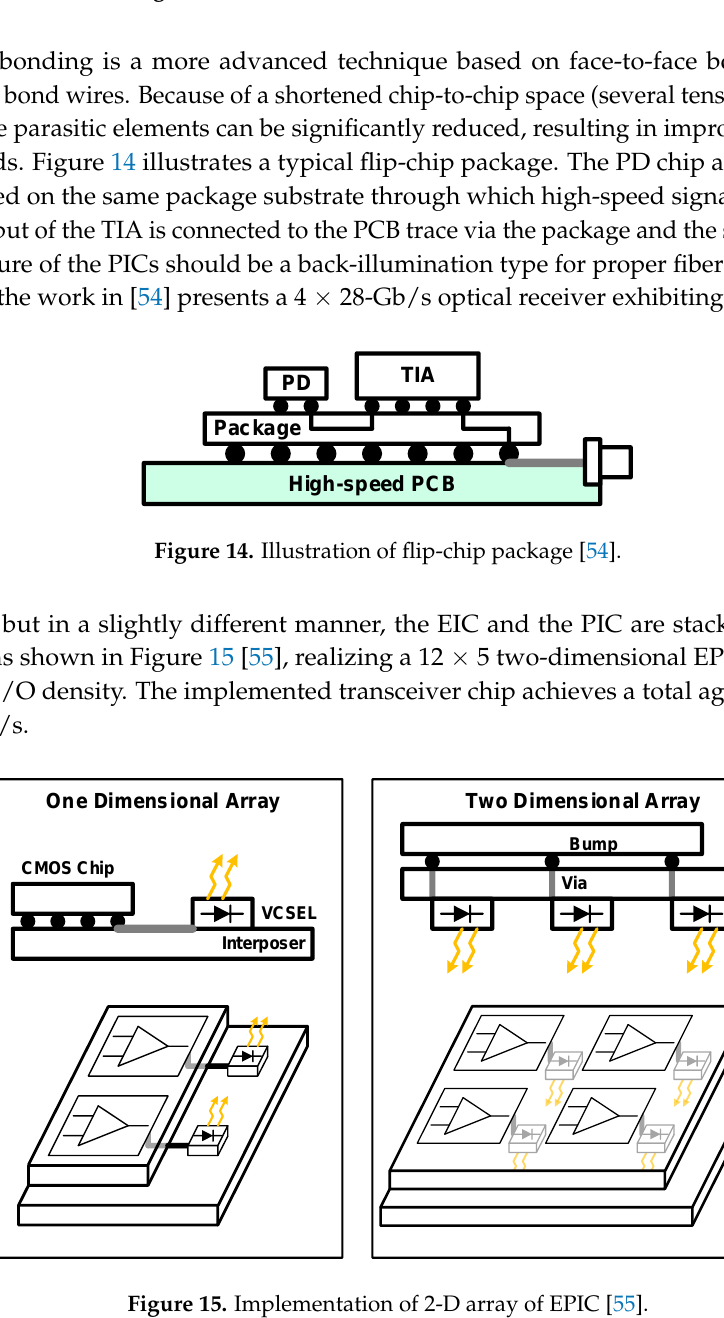
Figure 16. Flip-chip bonded EIC directly on PIC using micro bump [56].